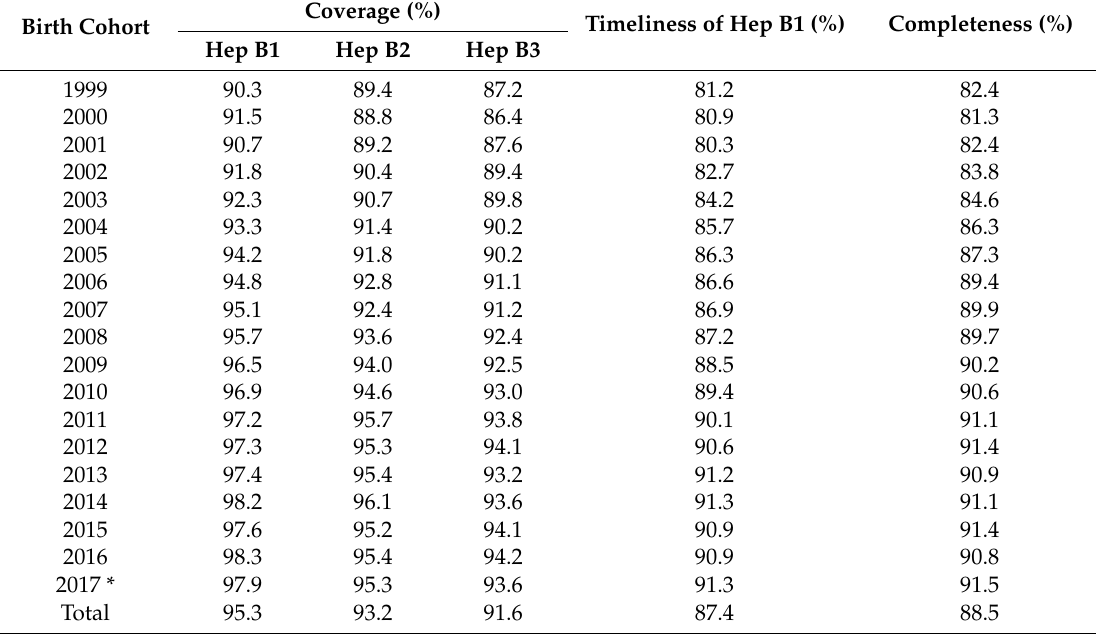
Table 2. The vaccination coverage, the timeliness of the first dose of hepatitis B vaccine (Hep B1), and the completeness of hepatitis B vaccination (Hep B) for birth cohorts from 1999 to 2017, Zhejiang province. Coverage (%) Timeliness of Hep B1 (%) Completeness (%) Birth Cohort Hep B1 Hep B2 Hep